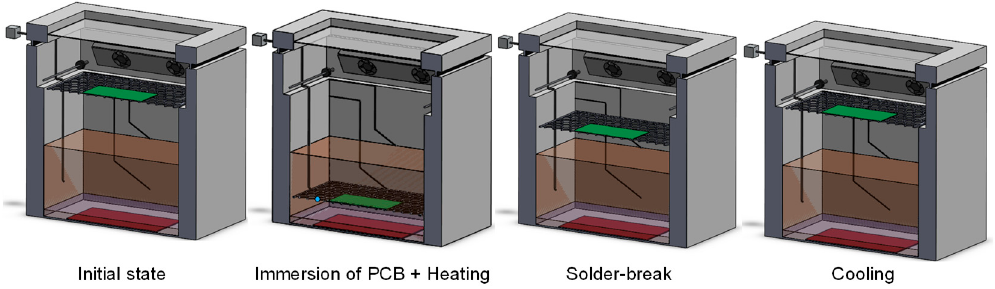
Figure 2. The phases of the heat-level VPS.